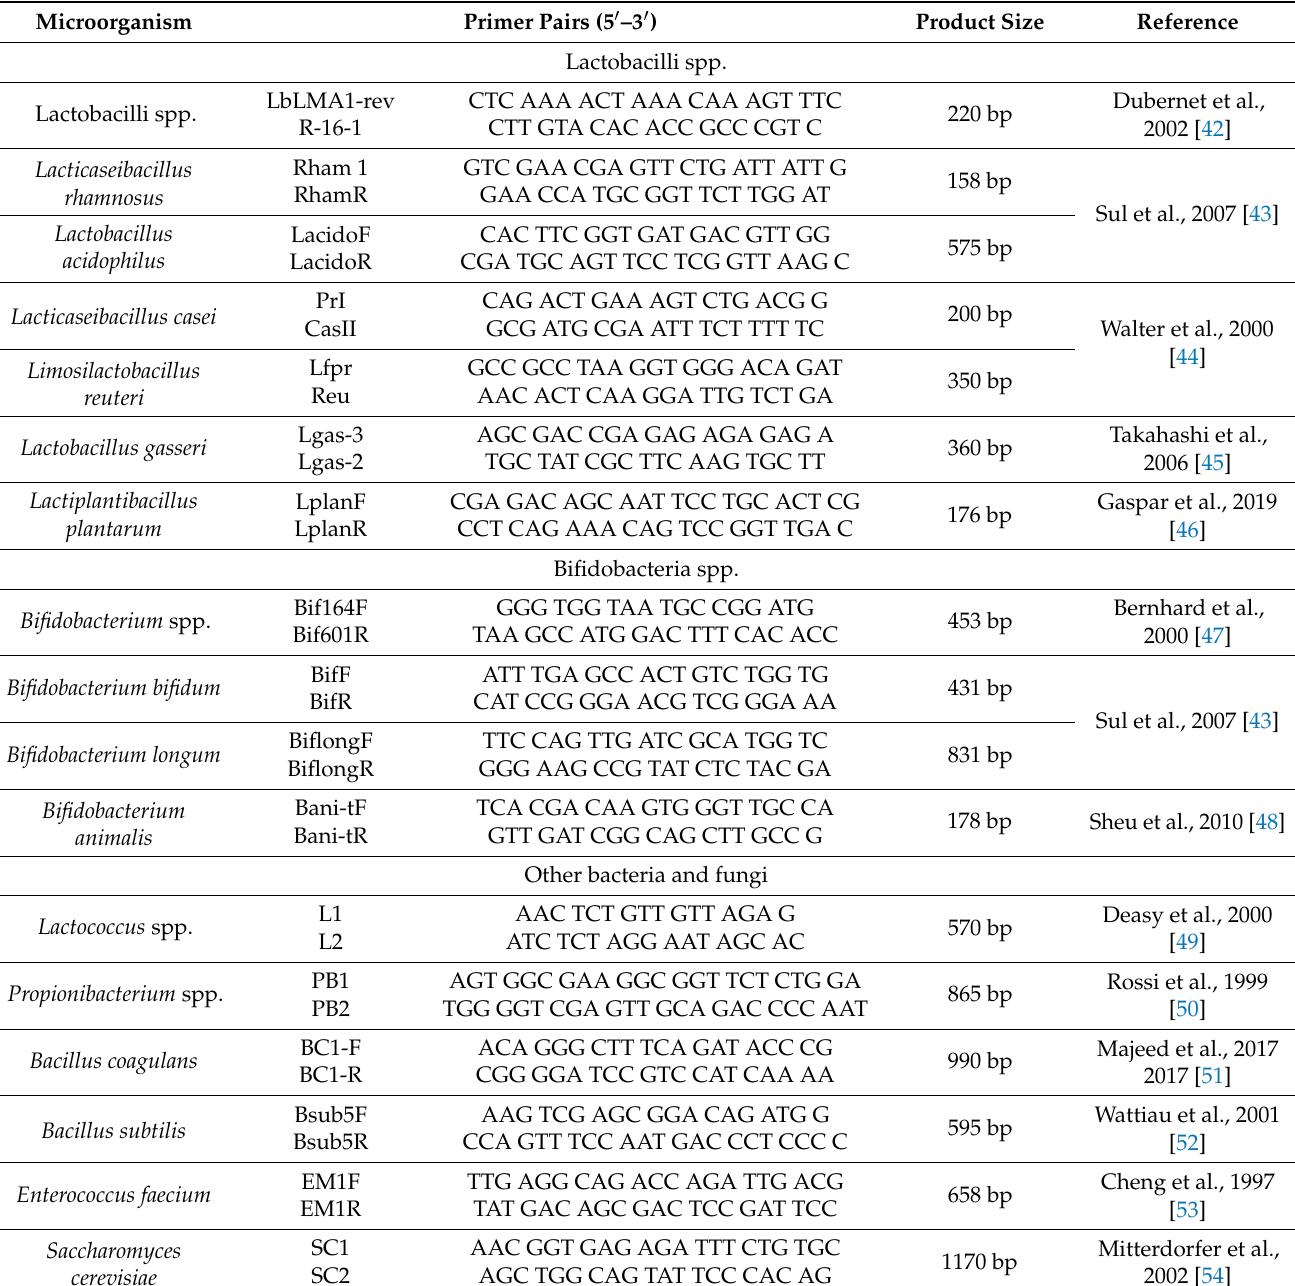
Table 4. Primer pairs of selected microbial genera or